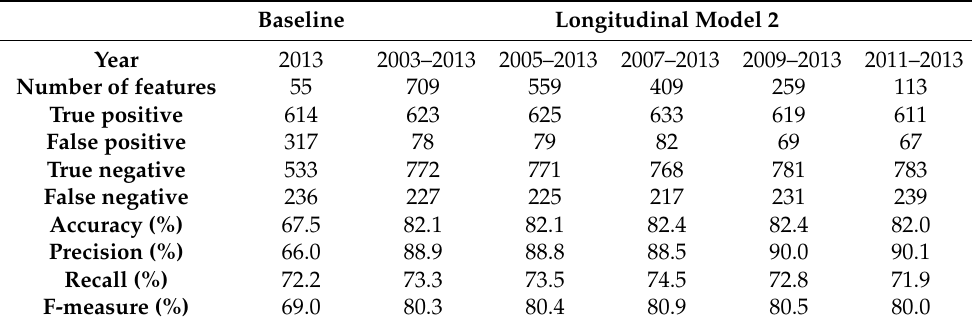
Table 9. Longitudinal model 2 (Best combination of MT-DB